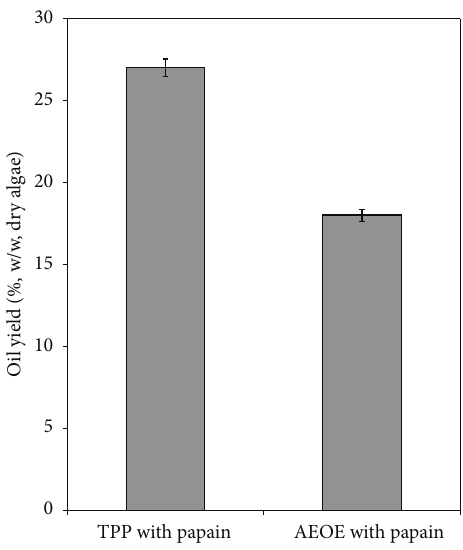
Figure 3: Activation of papain by TPP. The effectiveness of papain (presentduringthecourseofTPP)wasmeasuredintermsofoilyield with a control. The control was an AEOE under similar